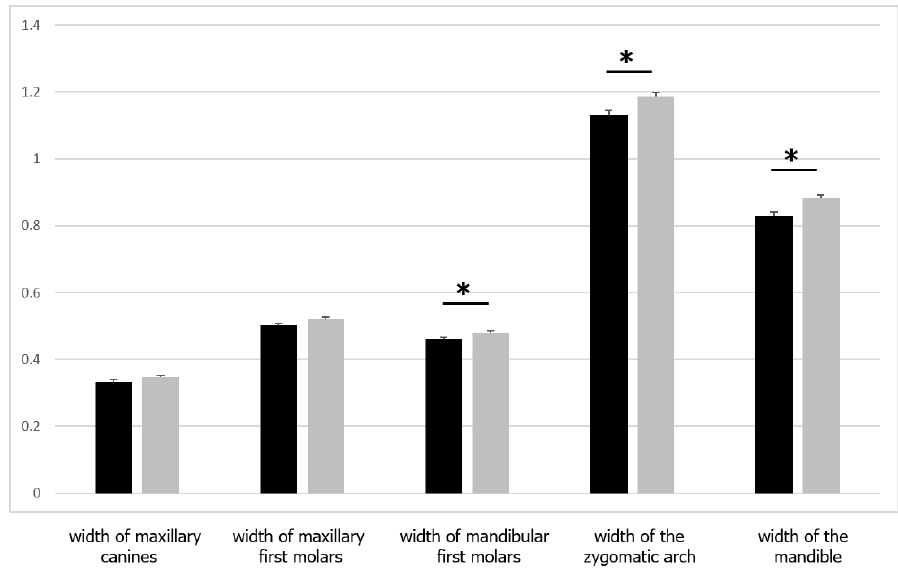
Figure 6. Comparison of the maxillary and mandibular width ratio between samurai and commoners. Values are presented as means ± standard deviations. The asterisks represent significant differences between the groups. Black, samurai group; grey, commoners.